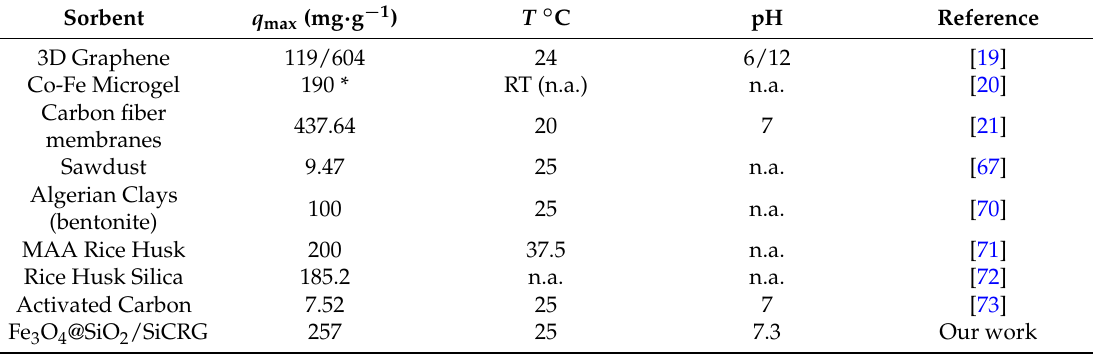
Table 5. Comparison of q max values for Fe 3 O 4 @SiO 2 /SiCRG and other reported adsorbents for paraquat removal from water. All q max values are presented, based on experimental